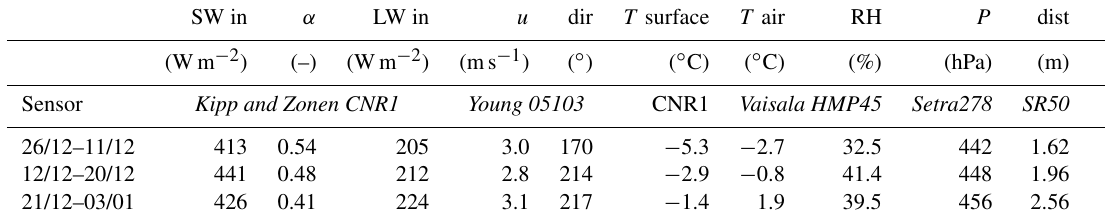
Table 2. Mean meteorological conditions during the measurement intervals: incoming shortwave (SW in), albedo ( α) , incoming longwave (LW in), wind speed ( u ), wind direction (dir), surface temperature computed from measured outgoing longwave radiation ( T surface), air temperature ( T air), relative humidity (RH), air pressure ( P ) and the distance between the sonic ranger and the glacier surface (dist). SW in α LW in u dir T surface T air RH P dist (Wm − 2 ) (–) (Wm − 2 ) (ms − 1 ) Kipp and Zonen